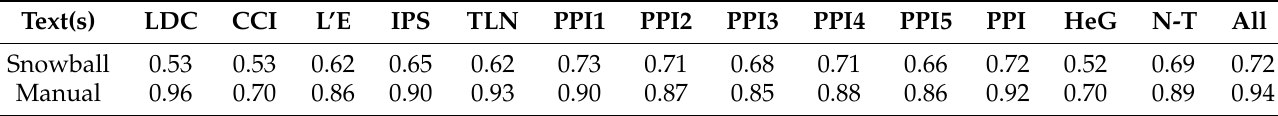
Table 4. Comparison of P@100 for Snowball-based and manual evaluation on Italian texts (from Reference [9]). Text(s) LDC Snowball Manual